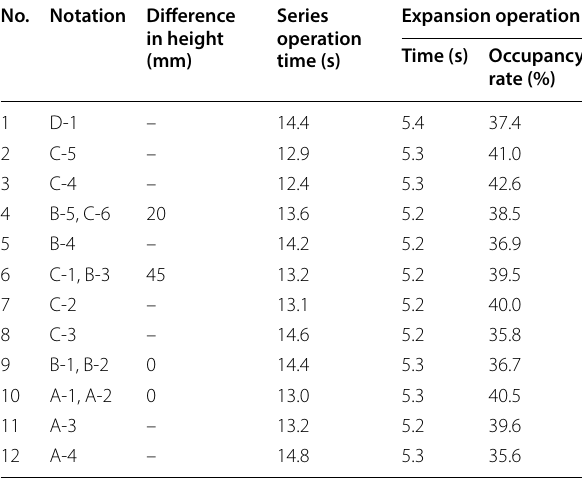
Table 8 Continuous unloading experiment results ③ No. Notation Difference in height